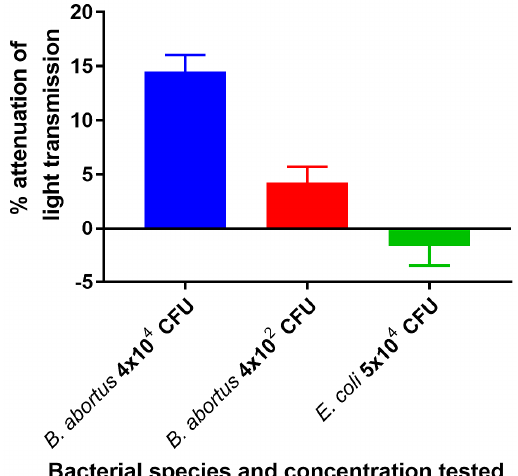
Figure 6. Detection of B. abortus DNA from lysates of killed cells by NOFS assay without